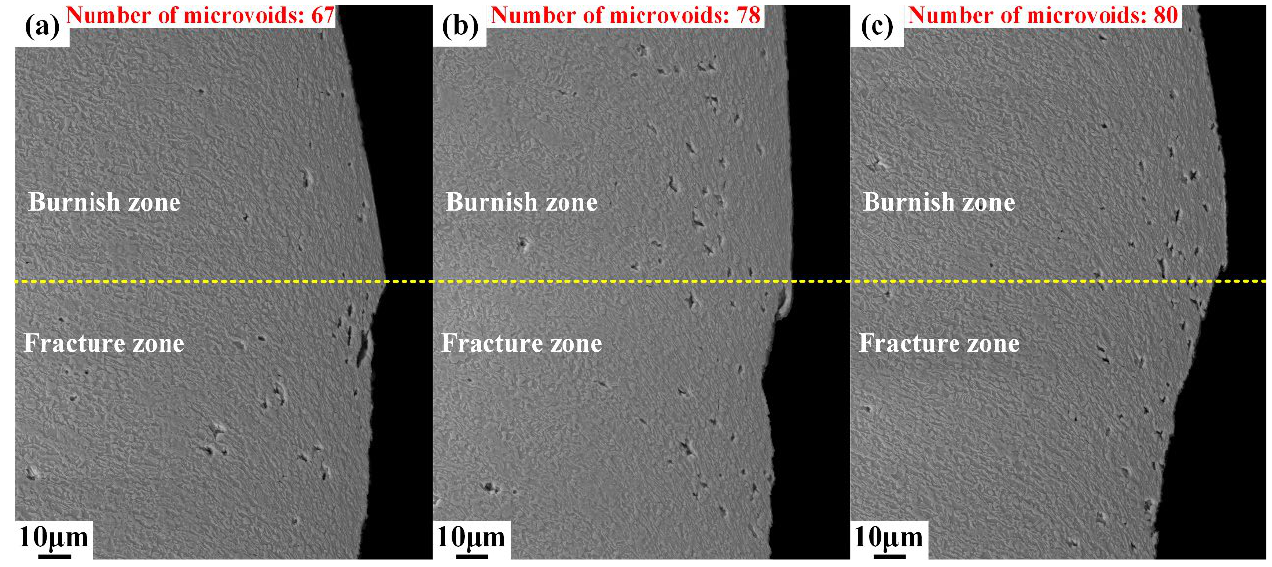
Figure 10. Microstructure of sheared edge in area II, obtained under different shearing clearances: